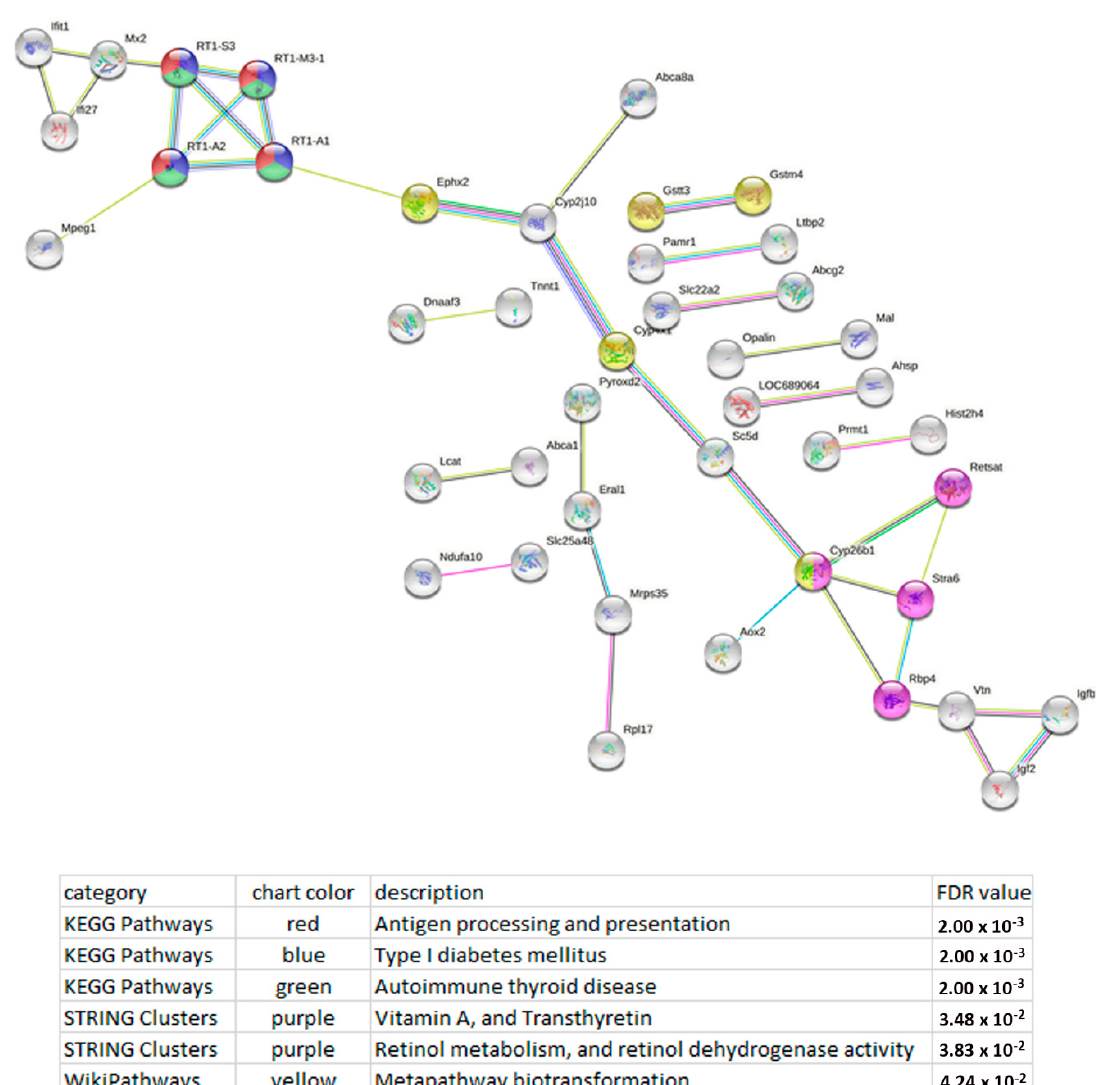
Figure 6. Functional enrichment analysis of the lncRNA Tnxa-ps1 network points to possible association of this lncRNA with several pathways: retinol metabolism, antigen processing and presentation, type 1 diabetes mellitus and metapathway biotransformation. The functional enrichment network was constructed by means of the STRING database [22] using the DEGs whose expression correlated with the expression of lncRNA Tnxa-ps1. Each node represents all the proteins produced by a single protein-coding gene. The key links associated with retinol metabolism are retinol binding protein 4 (Rbp4); cytochrome P450, family 26, subfamily b, polypeptide 1 (Cyp26b1); retinol saturase (Retsat); and signaling receptor and transporter of retinol STRA6 (Stra6). The key links associated with antigen processing and presentation and type 1 diabetes mellitus are RT1 class Ia, locus A1 (RT1-A1); RT1 class Ia, locus A2 (RT1-A2); RT1 class II, locus Bb (RT1-Bb); RT1 class Ib, locus M3, gene 1 (RT1-M3-1); and RT1 class Ib, locus S3 (RT1-S3). The key links associated with metapathway biotransformation are epoxide hydrolase 2 (Ephx2); cytochrome P450, family 4, subfamily x, polypeptide 1 (Cyp4x1); cytochrome P450, family 26, subfamily b, polypeptide 1 (Cyp26b1); glutathione S-transferase, theta 3 (Gstt3); and glutathione S-transferase mu 4 (Gstm4). Edges represent protein–protein associations. Purple lines indicate experimentally determined interactions; blue lines mean known interactions from curated databases; dark blue lines denote gene co-occurrence; black lines indicate coexpression; green lines denote results of text mining; and grey lines indicate protein homology. Protein–protein interaction (PPI) enrichment p -value: 9.75 × 10 − 6 .